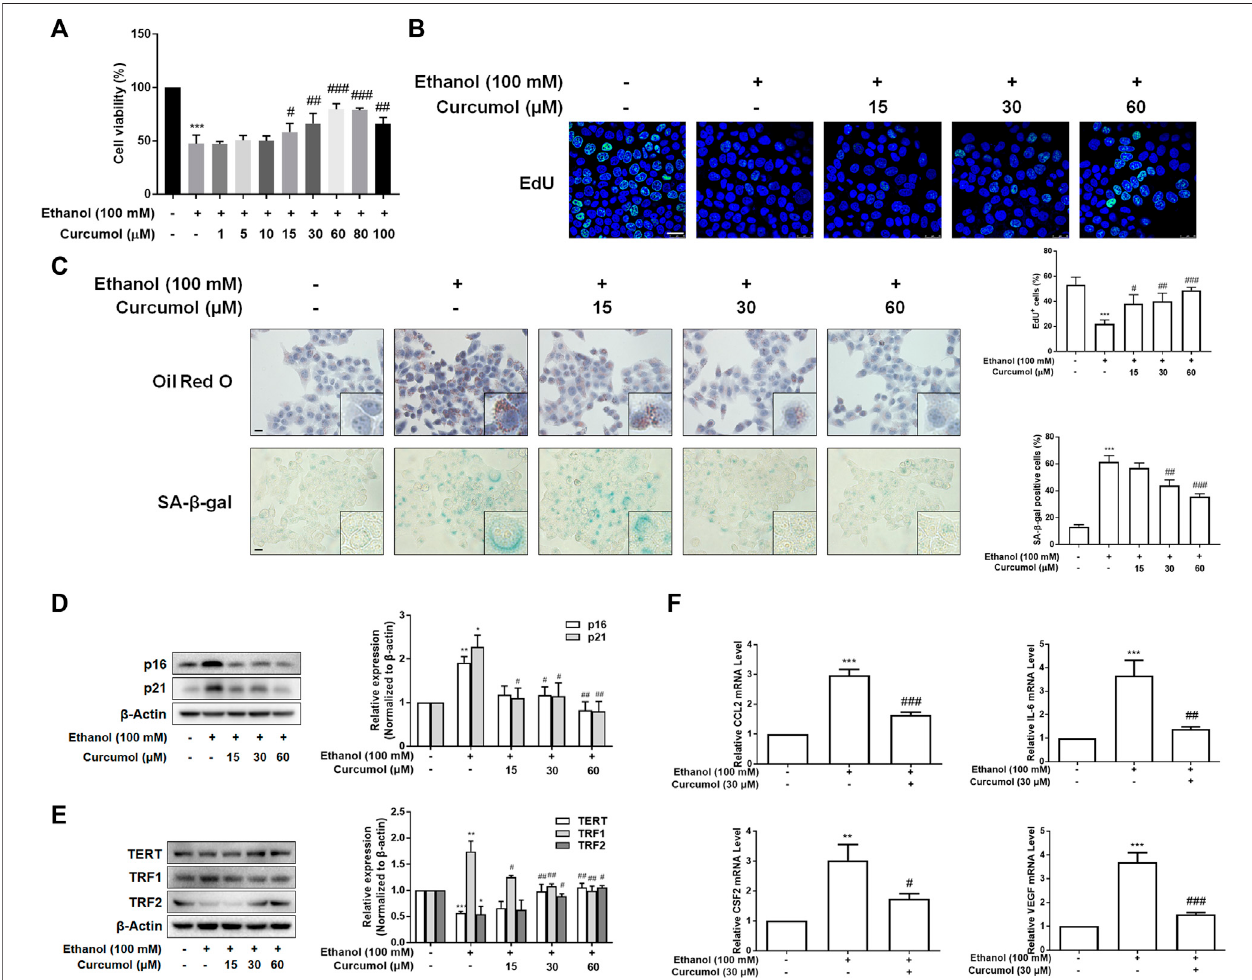
FIGURE 2 | Curcumol inhibited hepatocyte injury and senescence, which may be related to the inhibition of SASP factor secretion. When LO2 cells grew to 70% – 80% con fl uence, cells were incubated with 100 mM ethanol and different concentrations of curcumol for 24 h. (A) Cell Count Kit-8 analysis of cell viability, n = 6. Data are represented as mean ± SD. Signi fi cance: *** p < 0.001 versus control group, # p < 0.05, ## p < 0.01, and ### p < 0.001 versus ethanol group. (B) The representative images and quanti fi cation of EdU-positive cells in LO2 cells under indicated conditions ( n = 3). Scale bar, 25 μ m *** p < 0.001 versus control group, # p < 0.05, ## p < 0.01,and ### p < 0.001versusethanolgroup. (C) RepresentativeimagesofoilredOstainingandSA- β -galstainingofLO2cells, n =3.Scalebar,100 μ